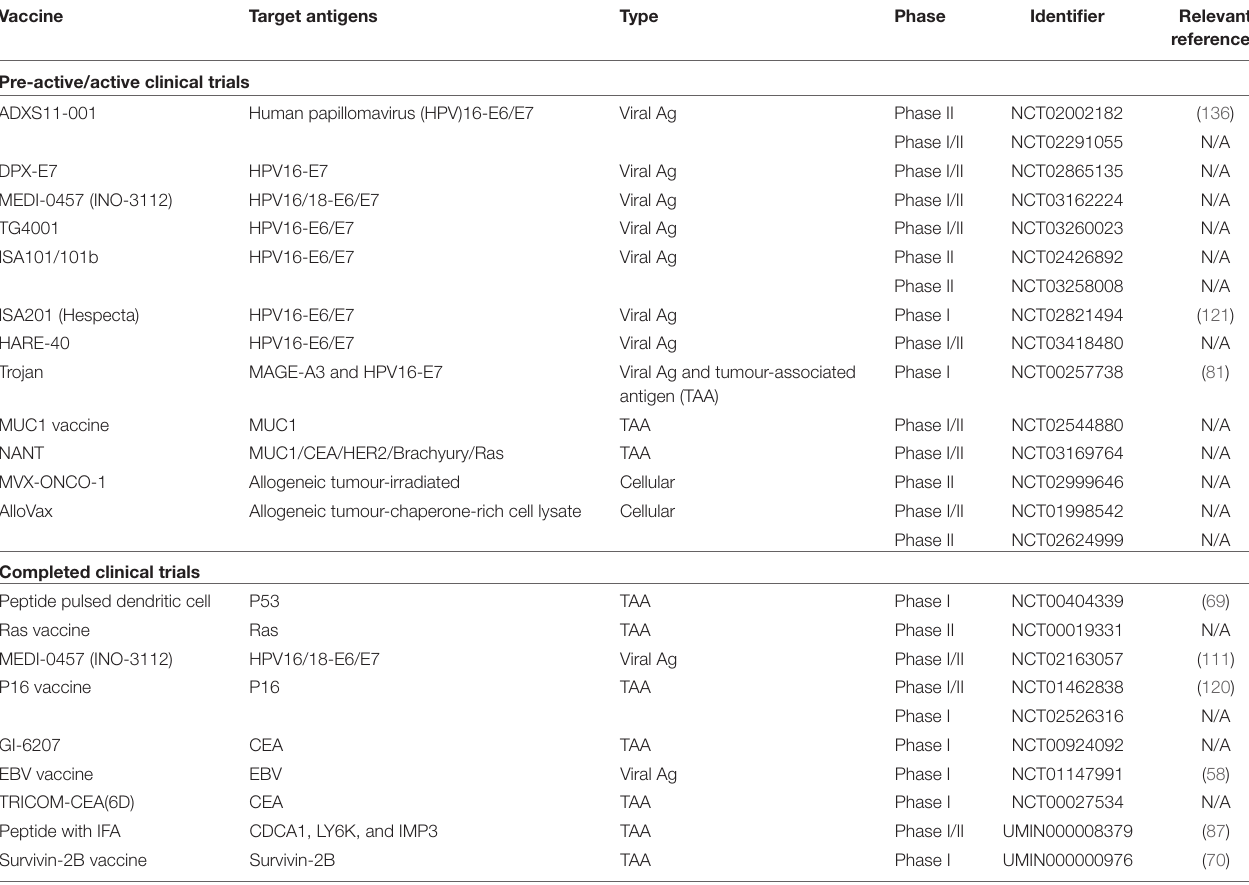
TABLe 1 | Target cancer antigens in head and neck